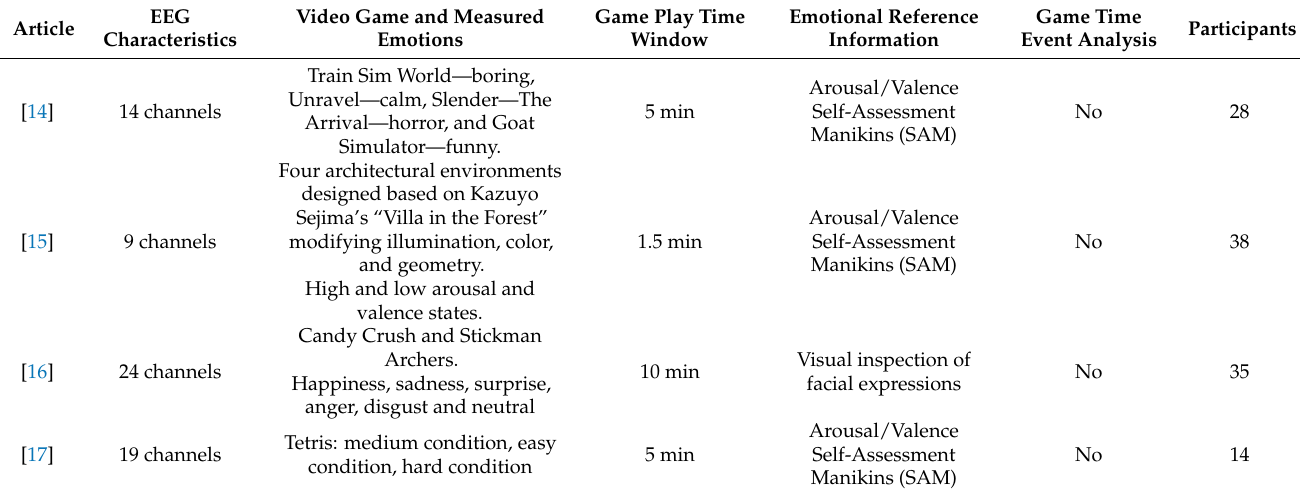
Table 1. Signal traits calculated for the physiological